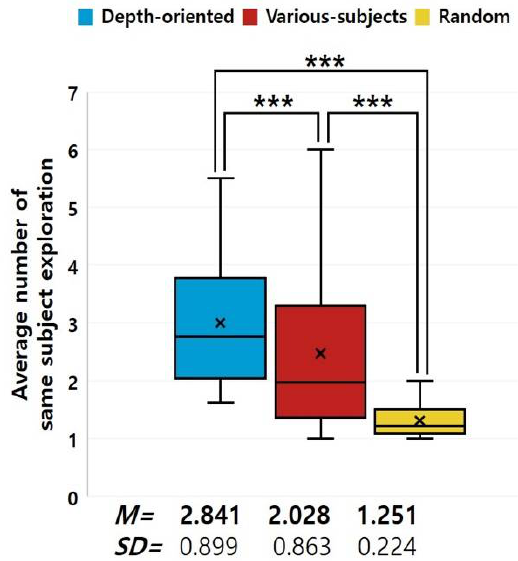
Figure 4. Comparison of information exploration for the same subject.